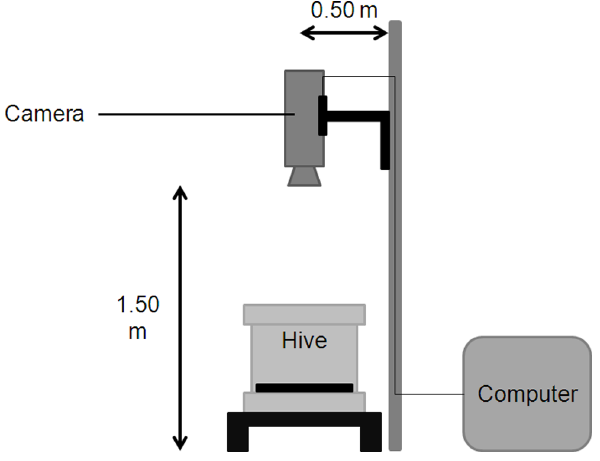
Figure 1. Position of the video camera above the entrance of each